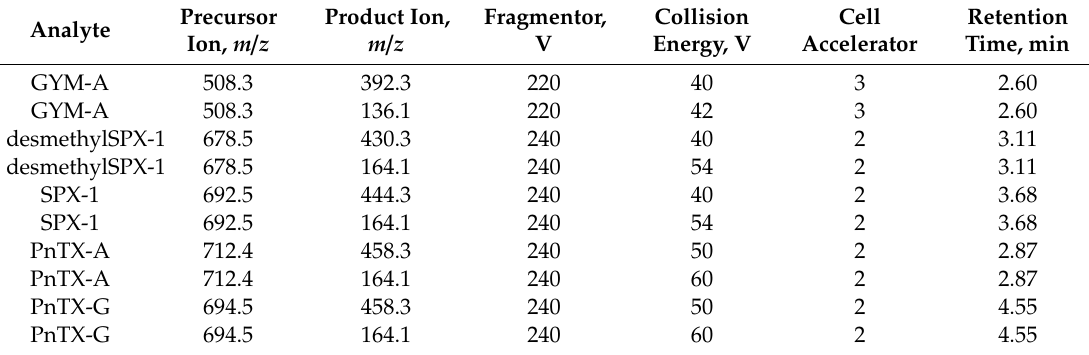
Table 1. MS / MS conditions used for the dynamic multiple reaction monitoring (DMRM) acquisition of data for cyclic imines (CIs) on a 6460 Agilent Technologies mass spectrometer with a retention window of 0.5